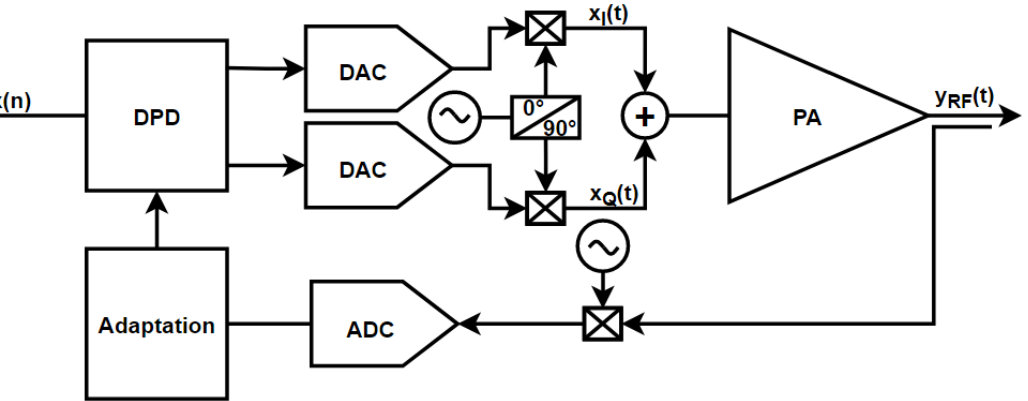
Figure 14. Mixed complex/real transmitter.